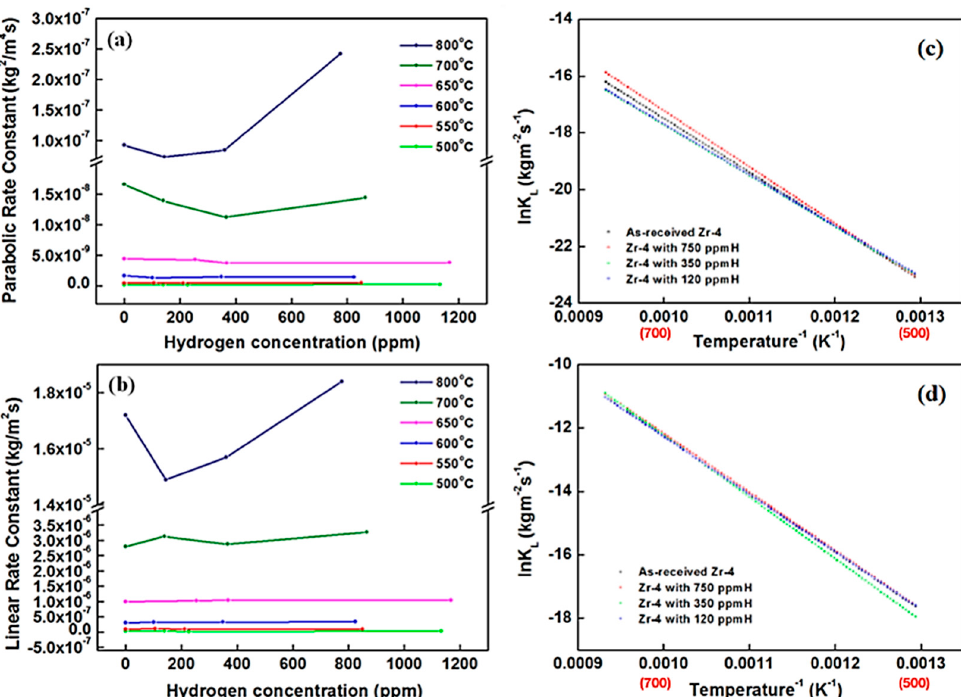
Figure 5. Variations in the ( a ) parabolic and ( b ) linear rate constants with the hydrogen concentration of the oxidized Zircaloy-4 specimens as well as the Arrhenius plots for the ( c ) pre-transition kinetics and ( d ) post-transition kinetics at 500–800 °C (in red) in air.